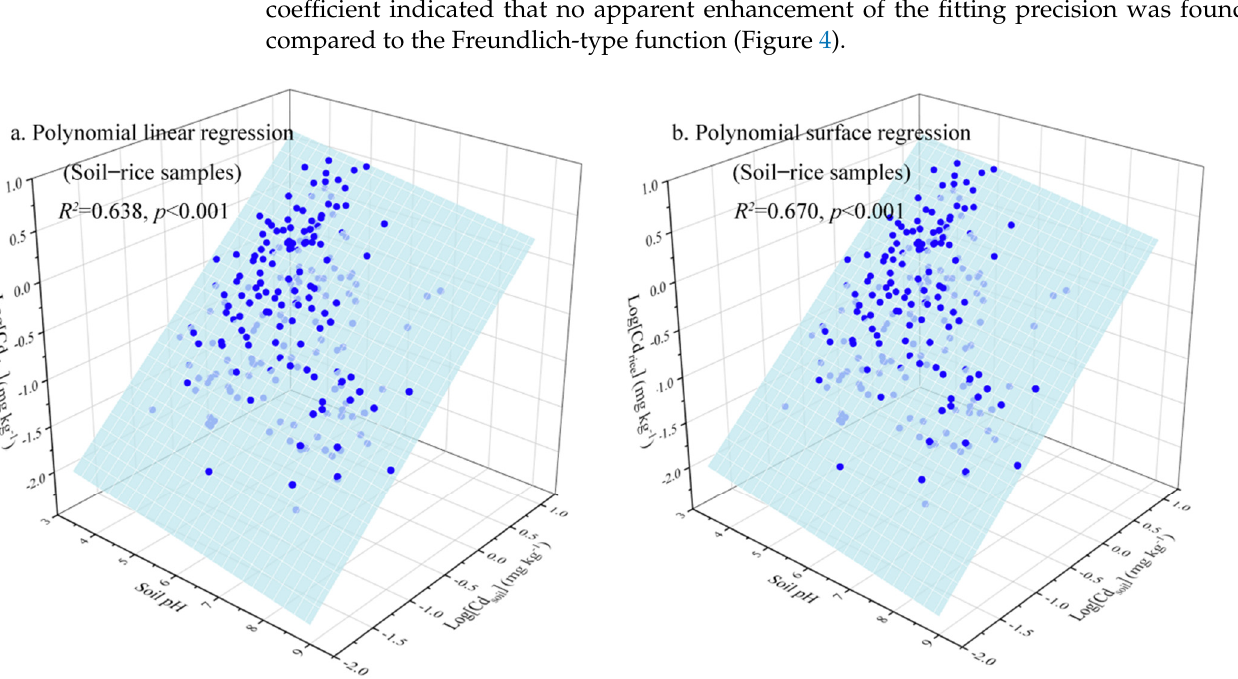
Figure 5. Relationships between the measured and predicted concentrations of Cd in rice grains. The red area represents the 95% prediction interval. 3.3. Species Sensitivity Distribution for Cd Accumulation As mentioned above, soil pH is the critical factor affecting Cd uptake in the soil–rice grain system. Thus, the model analyses were performed to construct the SSD curves based